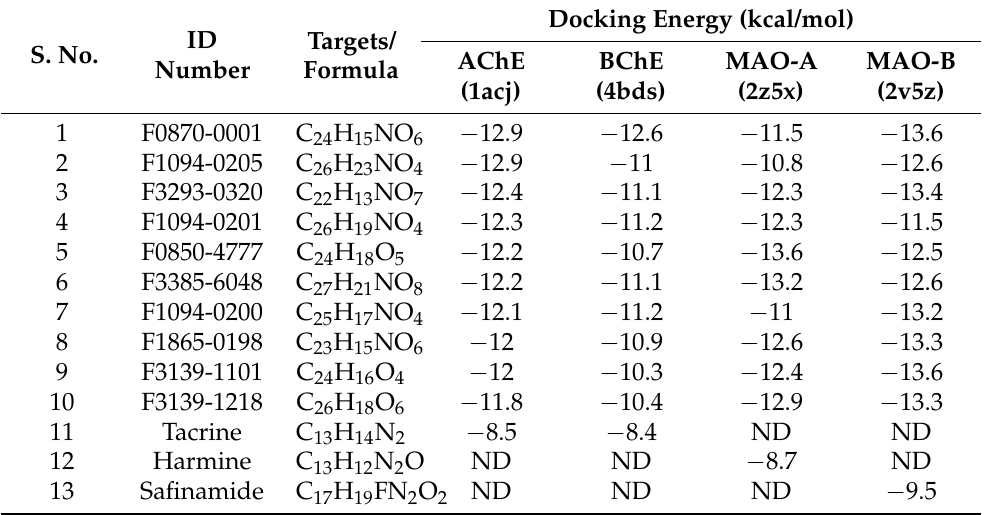
Table 1. Molecular docking scores of best hit natural product-like compounds against AChE, BChE, MAO-A and